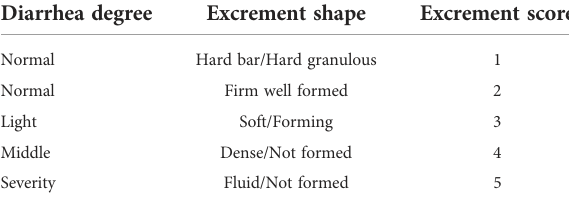
TABLE 1 Fecal scores